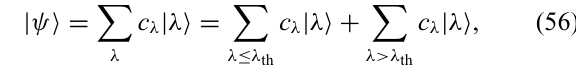
FIG. 7. A simple circuit for block encoding 1 projectors for which are, following QSVT conventions, | 0 (cid:6)(cid:8) 0 | ⊗ (cid:9) and | 0 (cid:6)(cid:8) 0 | ⊗ ˜ (cid:9) . (λ /α + 1 ) to within a precision (cid:16) 1 th 2